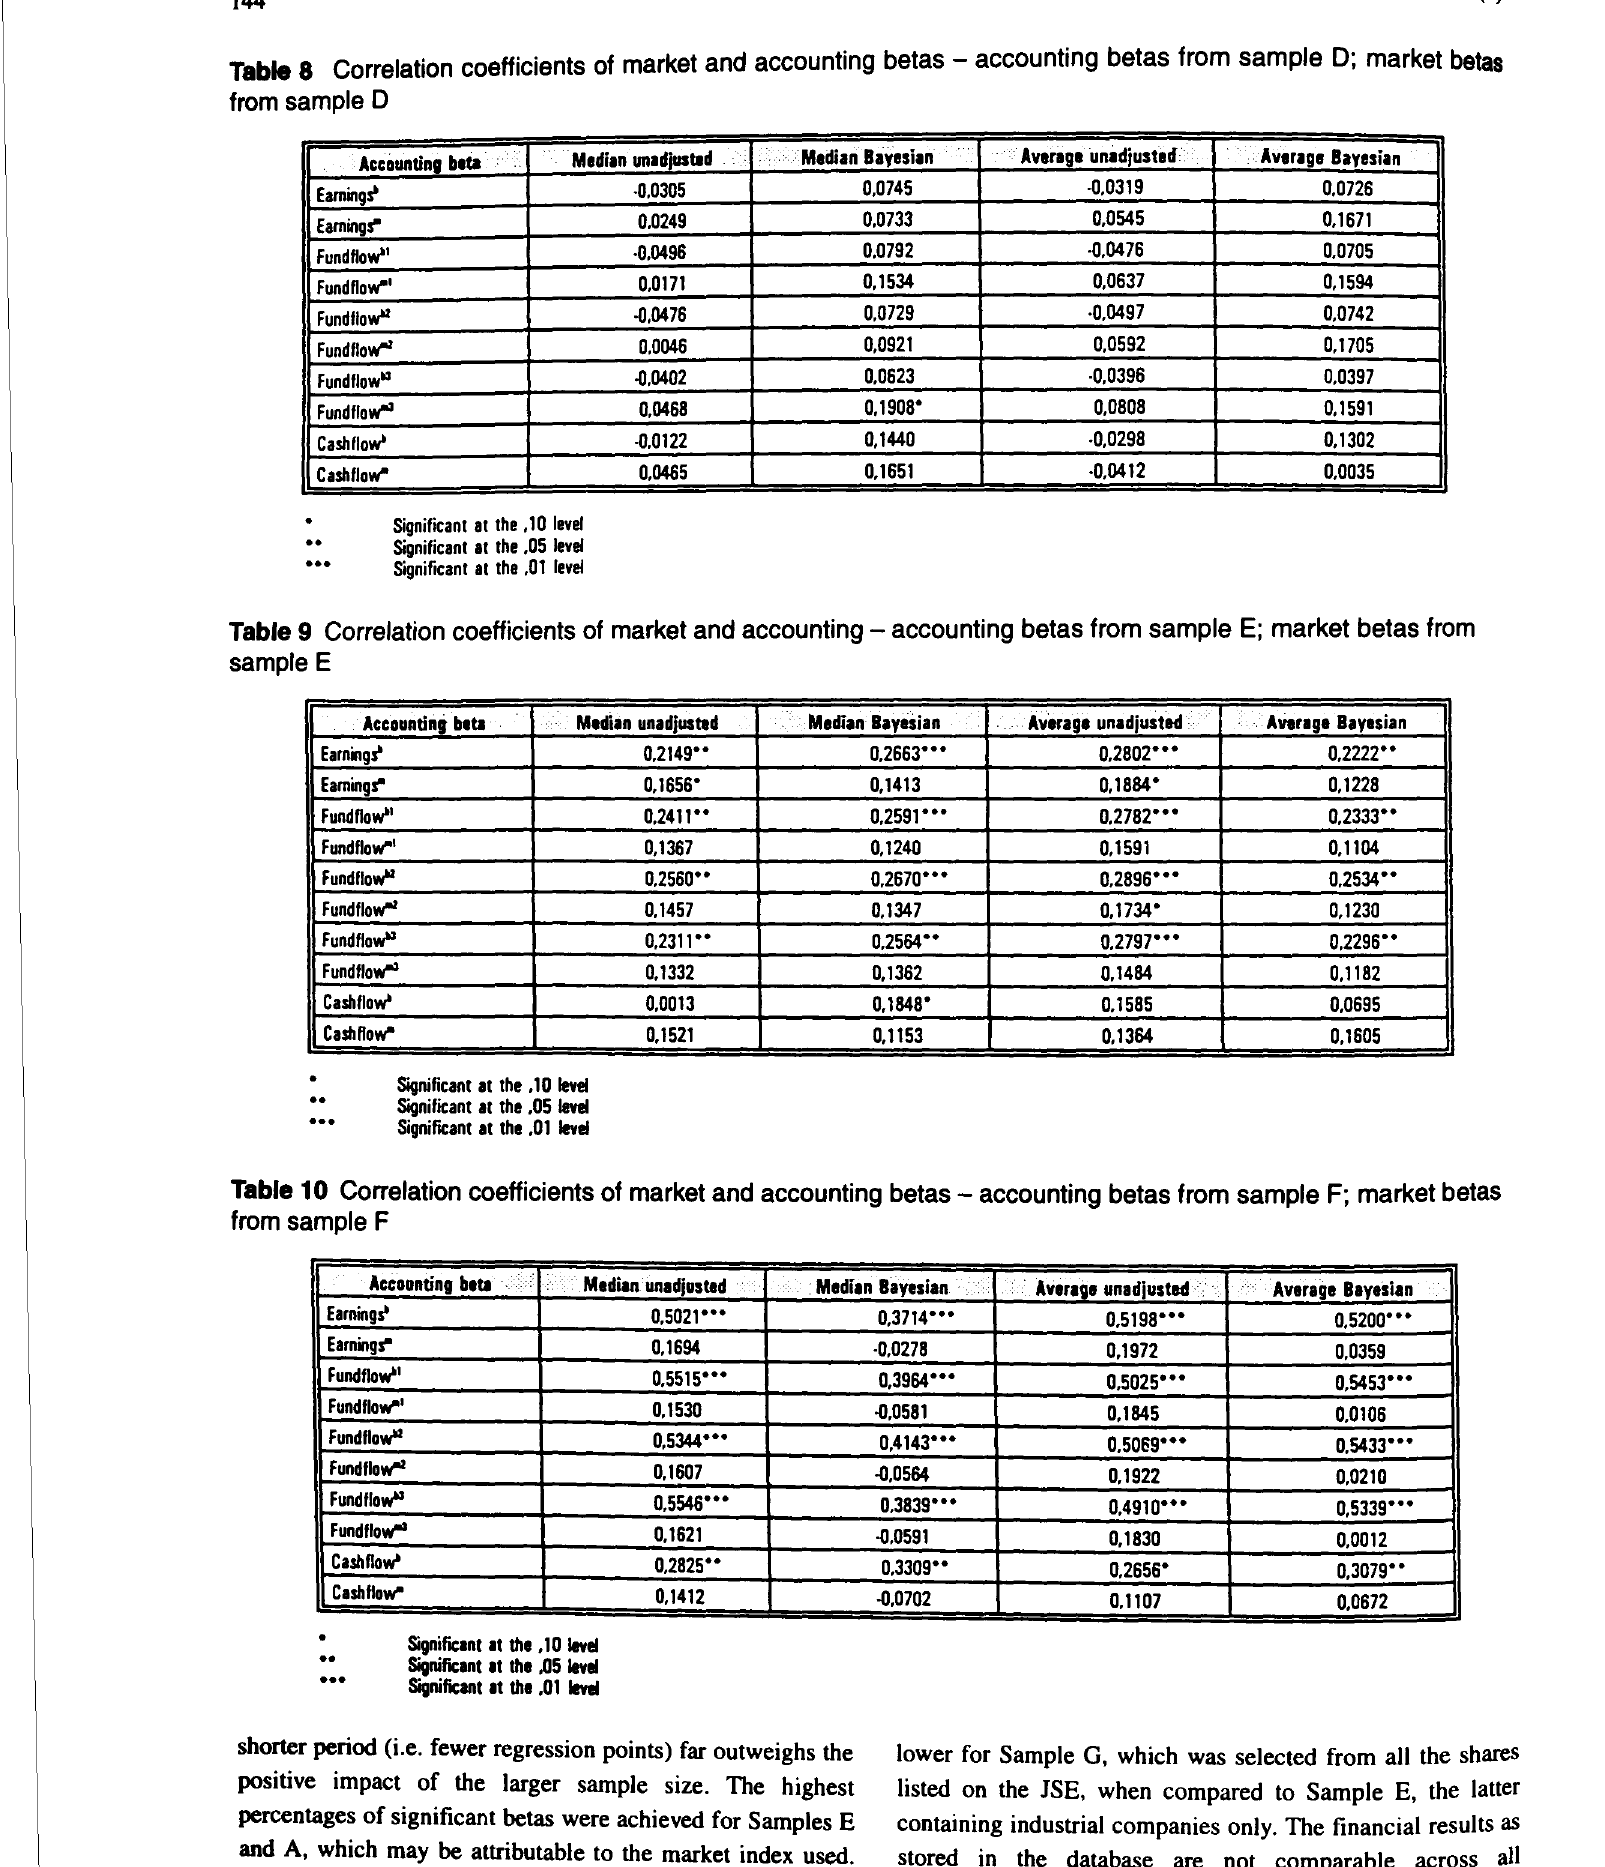
Table g Correlation coefficients of market and accounting - accounting betas from sample E; market betas from sample E